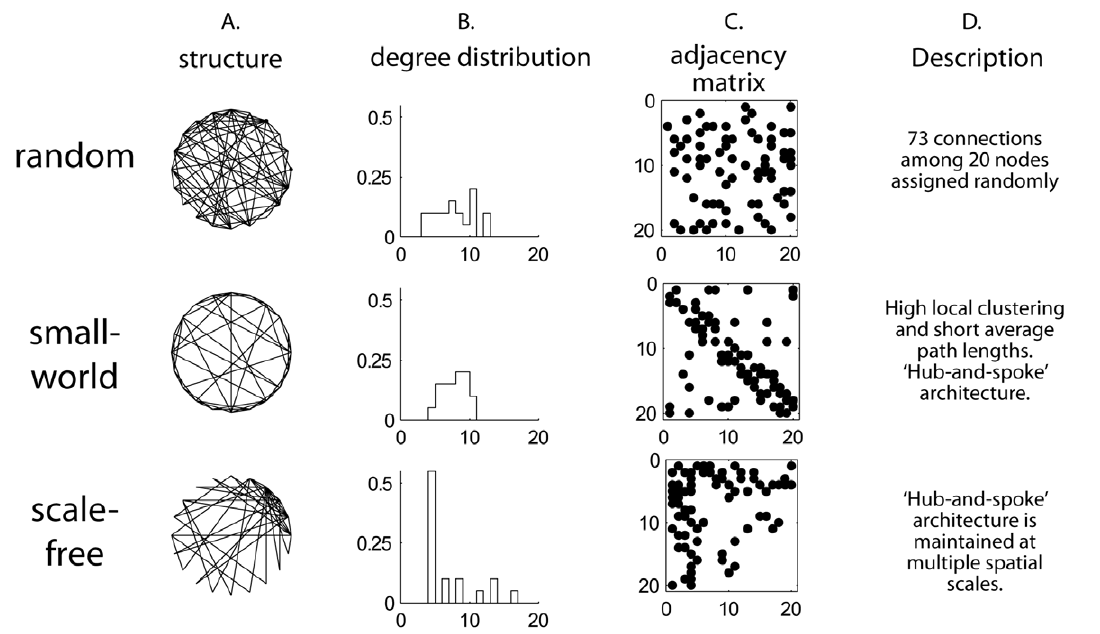
Figure 2. Properties of random and small-world graphs. Random, small-world and scale-free networks containing 20 nodes and 73 connections were generated by computer algorithms. The number of nodes and connections were chosen to be small to highlight differences between graphs. A. A structural representation of each graph. The nodes are arranged in a ring and connections are lines drawn between the nodes. The sparser appearance of the small-world graph occurs because most connections are between nearest neighbors along the perimeter of the ring, whereas in the random graph, short and long distance connections are equally probable. The scale-free graph has a hub in the upper right portion of the graph. B. Degree distribution. In random graphs, degrees are roughly normally distributed. In the small-world network, the degree distribution has a smaller standard deviation relative to random graphs because most nodes have a similar connectivity pattern. The scale-free graph has a ‘‘power-law’’ (approximately exponential) degree distribution. C. Adjacency matrices. Both axes show node number, and connections are represented as dots in the matrix. There is a uniform distribution of connections in the random graph. The thick diagonal band in the small-world distribution results from the high frequency of connections between nodes in neighboring positions on the ring. The thick horizontal and vertical bands in the adjacency matrix for the scale-free network correspond to hubs. D. Description of connectivity patterns.